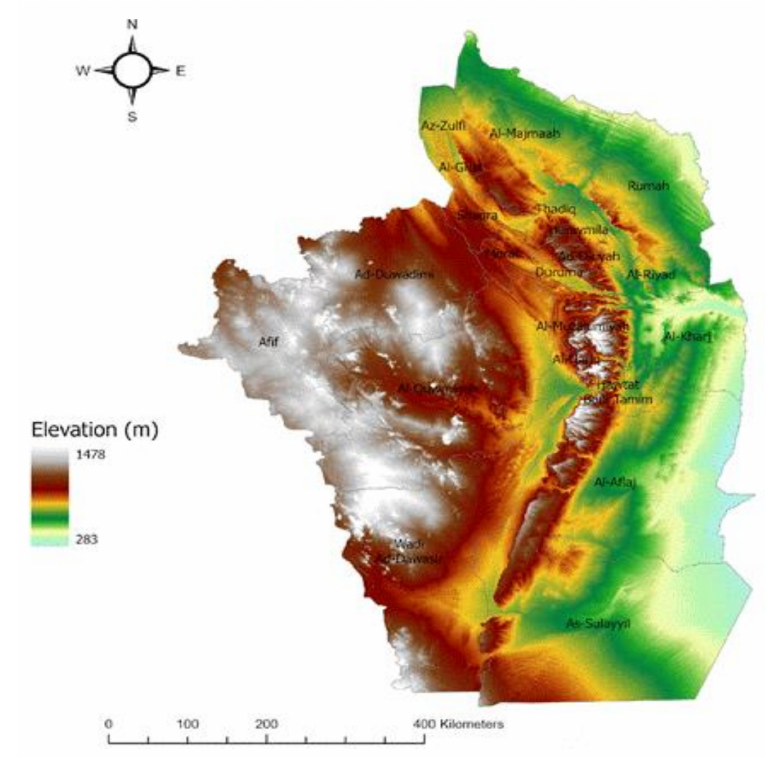
Figure 1. Study area